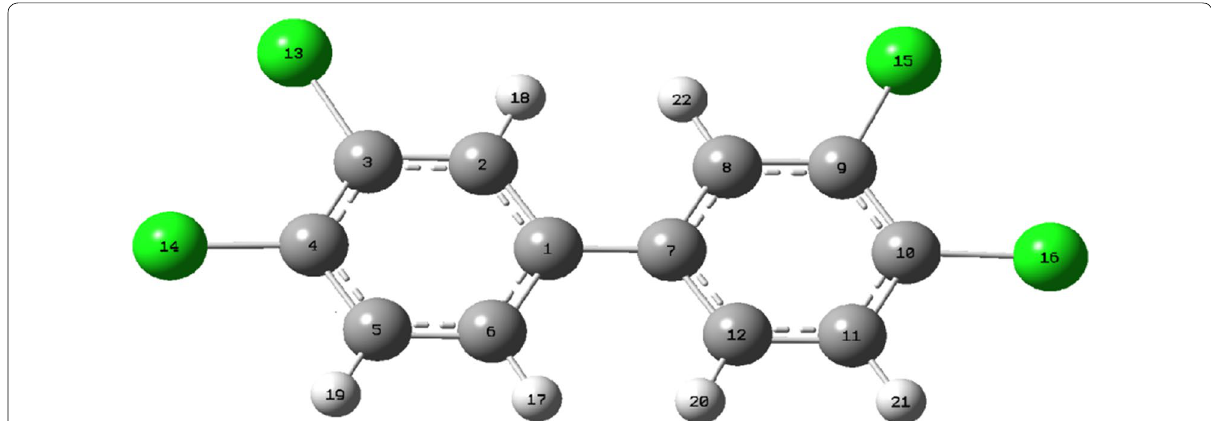
Fig. 1 Optimized structure of